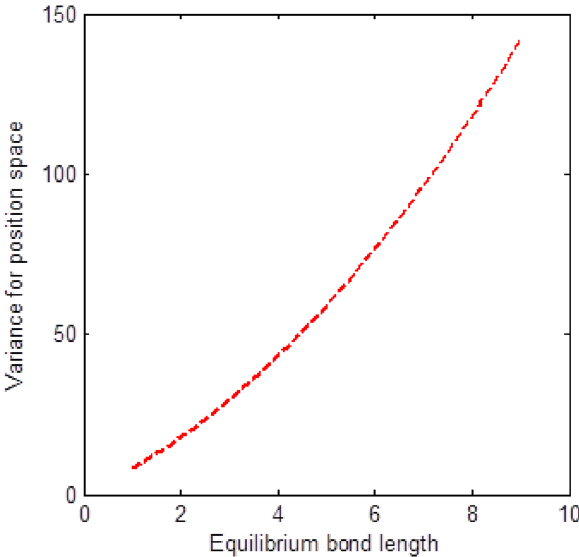
Figure 6. Variance for position space against the equilibrium bond length with µ = n = ℓ = (cid:31) = D e = C = 1, and (cid:31) = 2 C of the multiple potential functions.